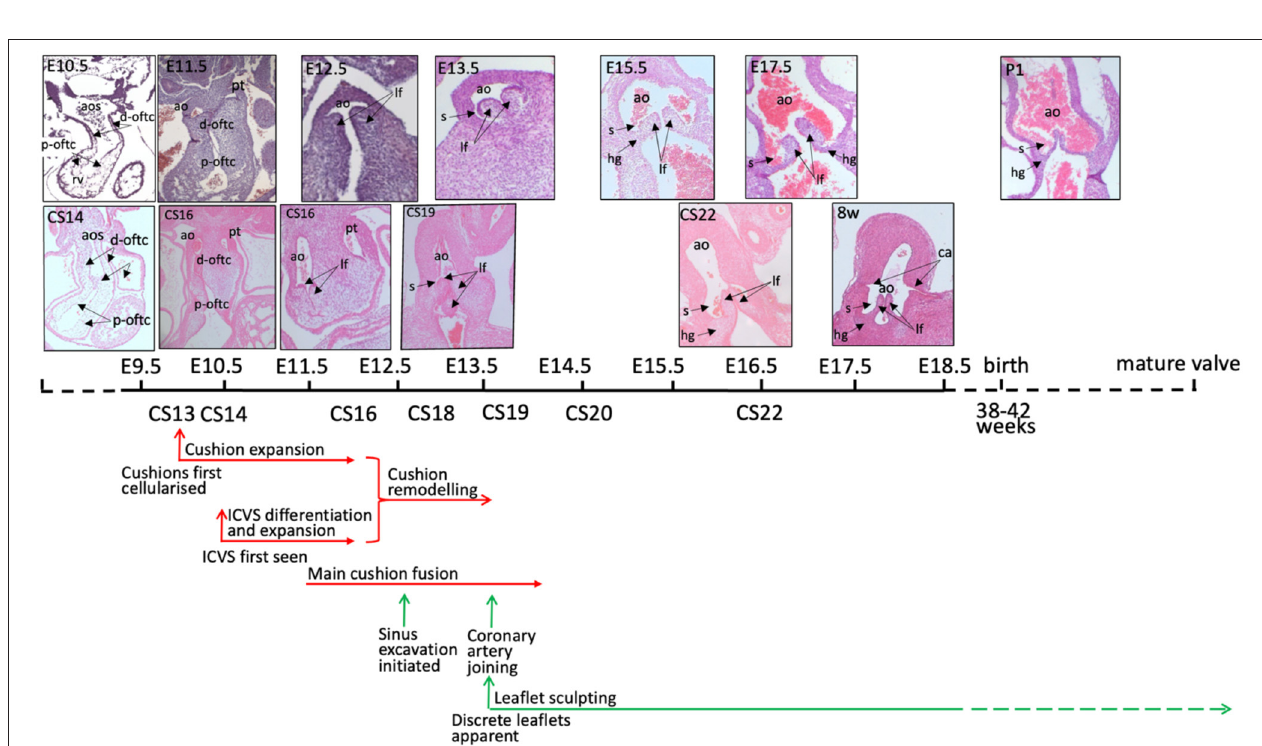
FIGURE 1 | Cartoon illustrating the components of the mature aortic valve. Dotted lines denote longitudinal and cross-sections through the valve complex. L, left; R, right; P, posterior.